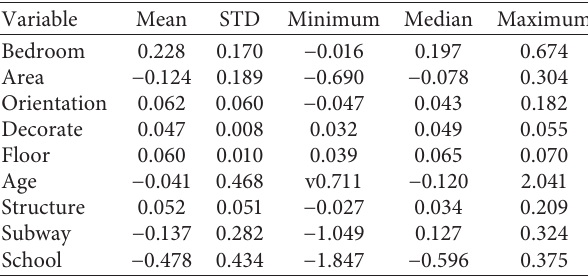
Table 5: Statistical description of MGWR